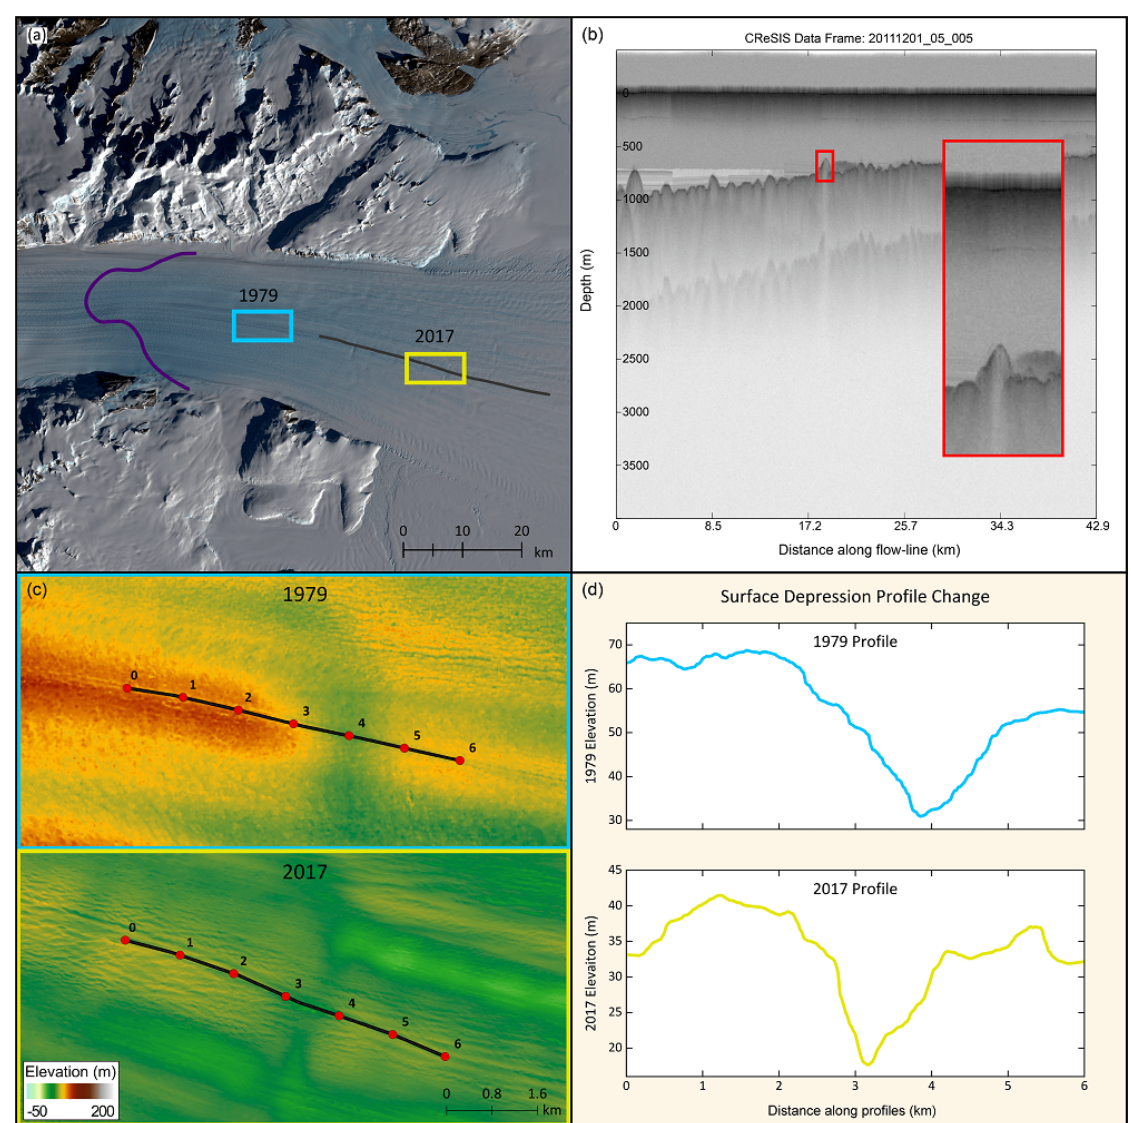
Figure 13. Surface depression geometry: The boxes in ( a ) show the locations of the depression in 1979 and in 2017 with a 2019 Landsat 8 OLI image in the background. The grey line passing through the yellow box is the CReSIS flight path for the echogram in ( b ). ( b ) A CReSIS echogram collected in 2011. The red box highlights the basal crevasse replaced[id=SFC](responsible for generating the surface depression) which is enlarged and also outlined in red. responsible for generating the surface depression. ( c ) 1979 (blue box in ( a )) and 2017 (yellow box in ( a )) DEMs and profile lines over the surface depression. While the profile lines are the same length, they follow slightly different flow paths which is due to the ice spreading as it leaves the fjord and enters the ice shelf. ( d ) Plots of the elevations from the profiles in ( c